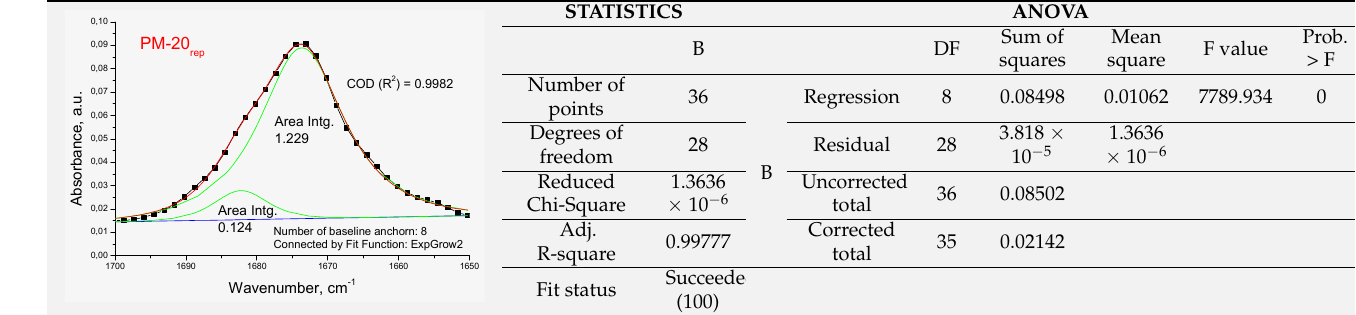
Table A9. Sample P-20 rep.